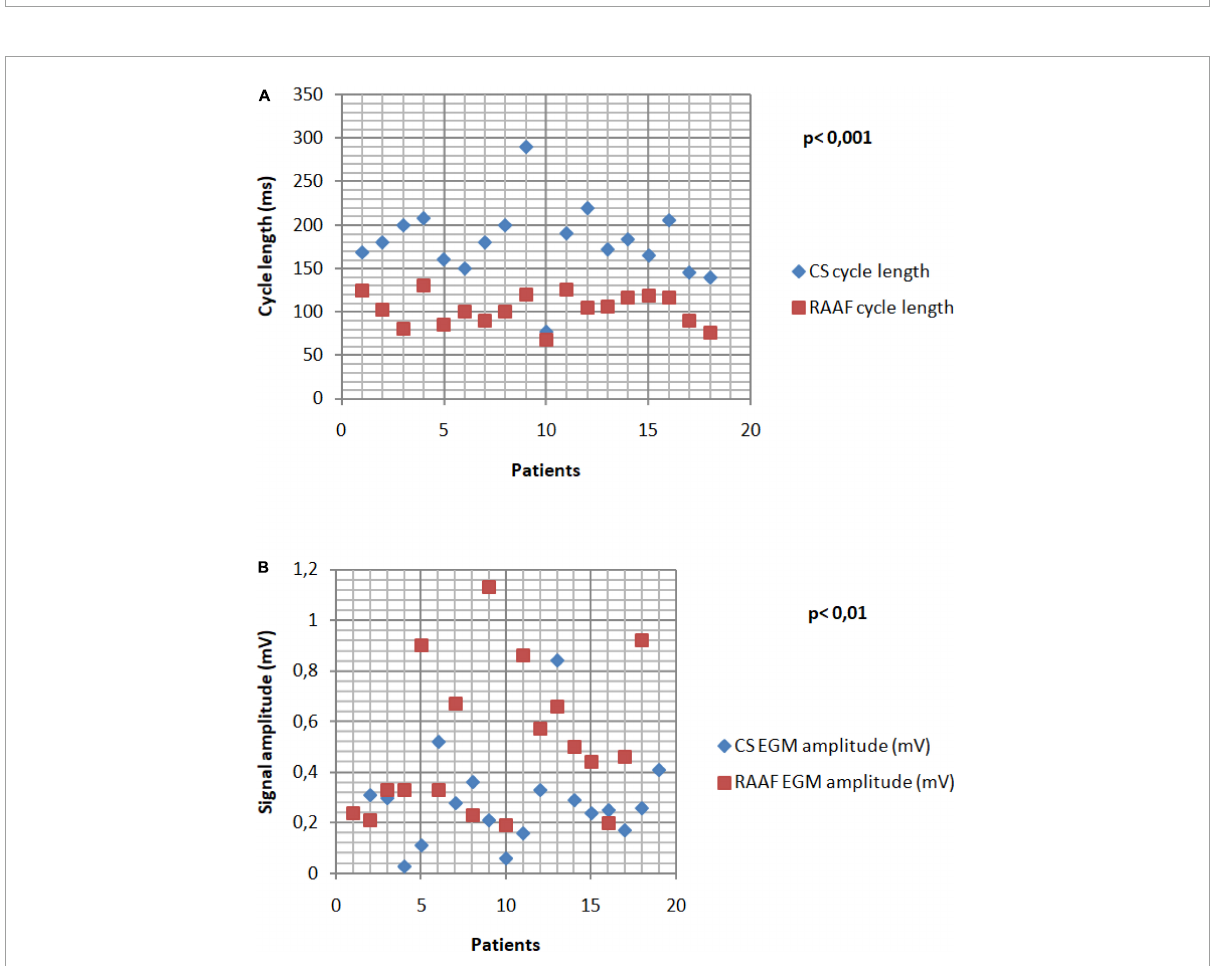
FIGURE4 Right Atrial Appendage Firing (RAAF) EGM analysis. The cycle length analysis shows fast drivers with a mean cycle 1.94 shorter than the CS CL ( p < 0.001) (A) . The RAAF cycle lengths were found between 76 and 130 ms. High voltage signals observed in the thick areas of the RAA and crista terminalis (B) . All the data were calculated as the average of ten consecutive